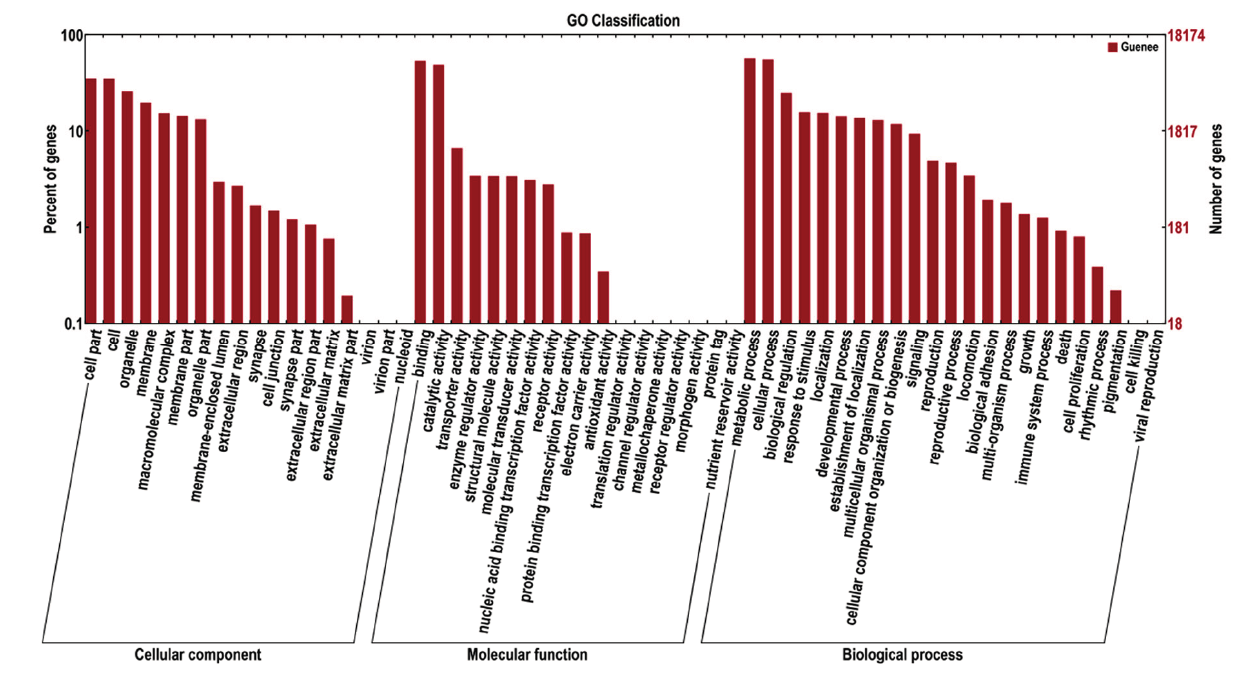
Figure 2. Functional annotation of assembled sequences based on gene ontology (GO) categorization. GO analysis was performed at the level two for three main categories (cellular component, molecular function, and biological